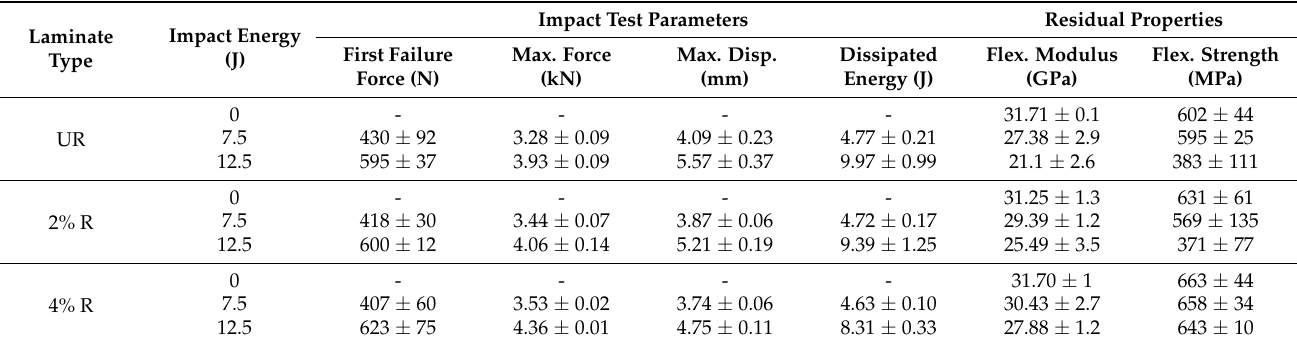
Table 1. Low-velocity impact and post-impact flexural characteristic parameters.